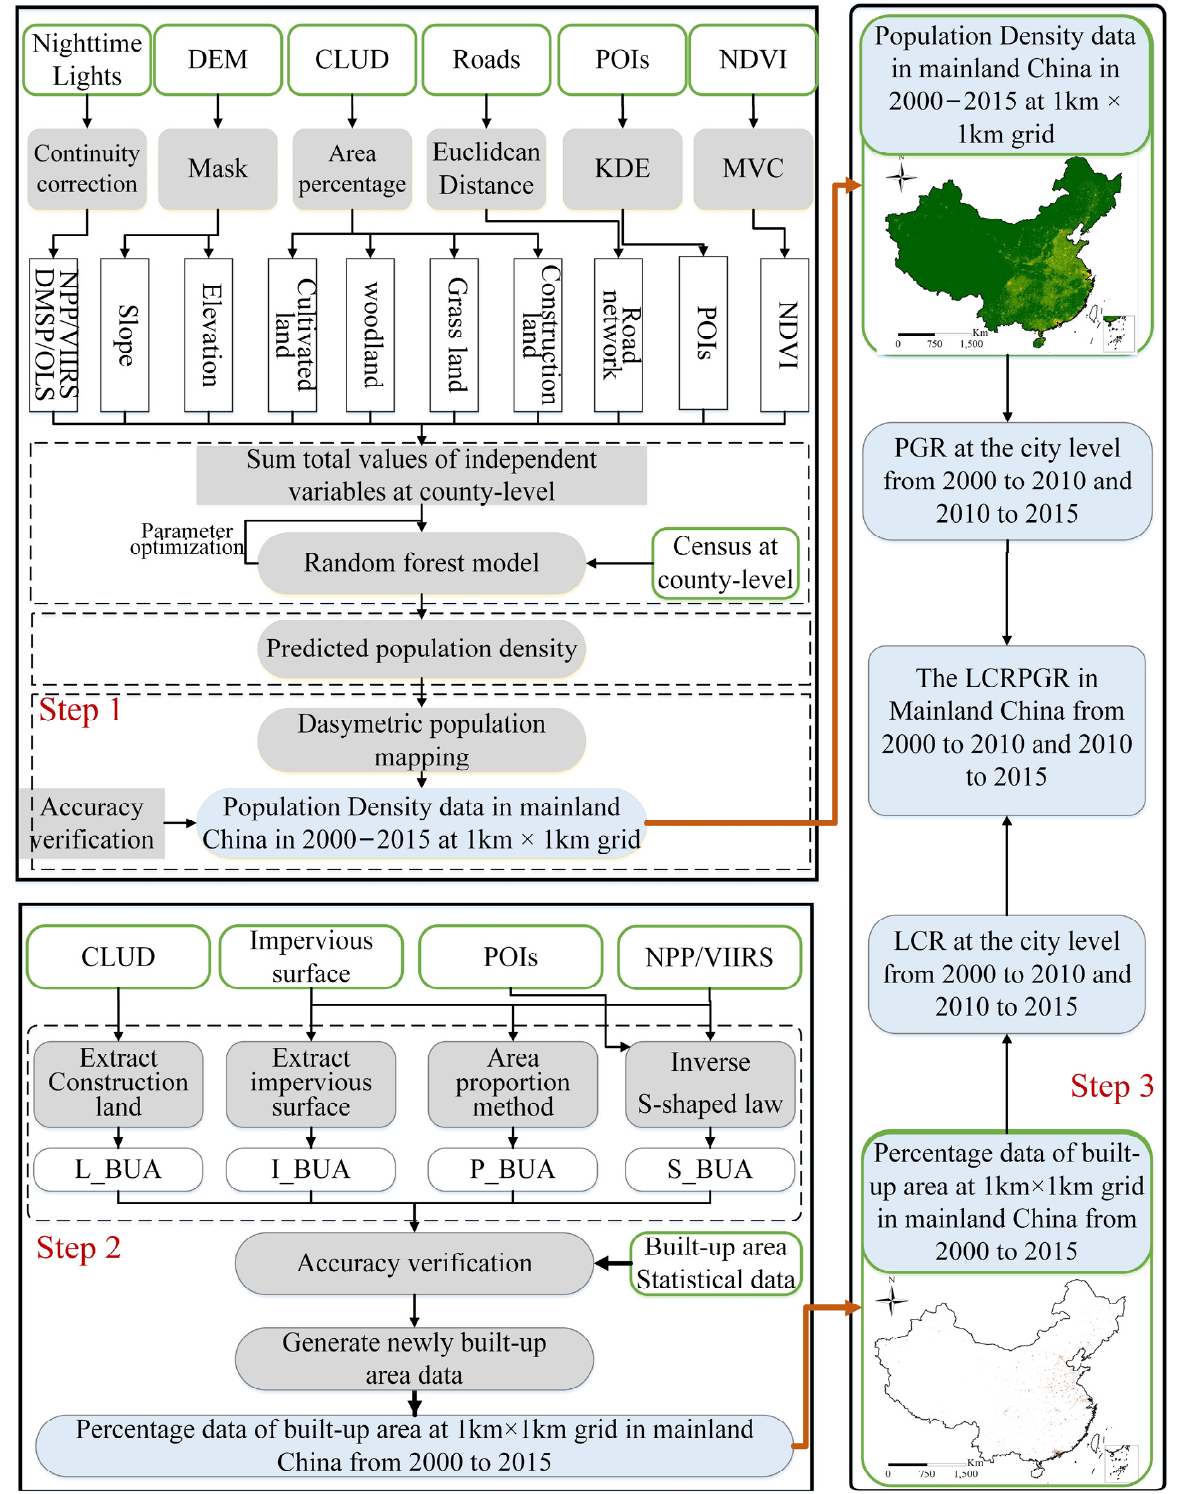
Figure 1. Flowchart. S_BUA and P_BUA data represent a built-up area obtained based on the inverted S-shaped law and area proportion method, respectively. The I_BUA and L_BUA data represent a built-up area obtained from global artificial impervious area (GAIA) and China land cover data (CLUD data), respectively. KDE, kernel density estimation; MVC, maximum value composite.